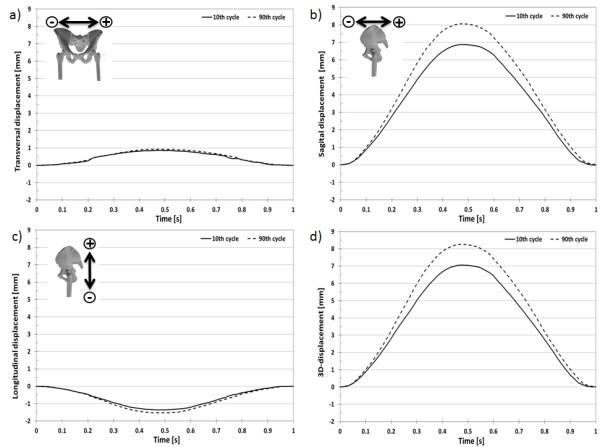
3D-displacement of the acetabulum marker. 3D-displacement of the marker at the acetabulum at the 10th and 90th loading cycle with a sinusoidal load between 100N and 900N.